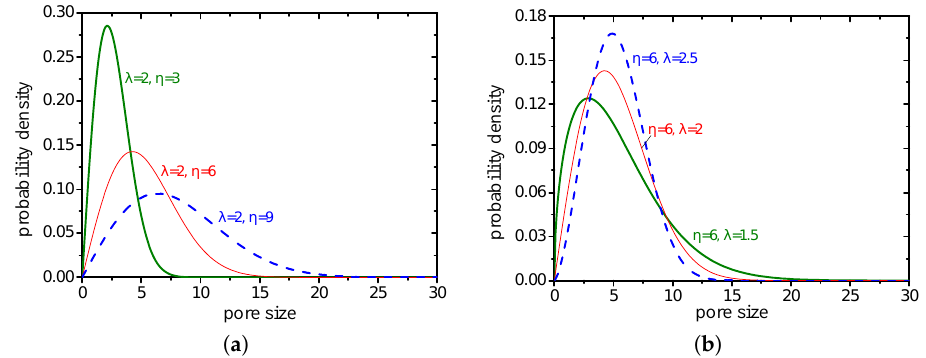
Figure 23. Effects of parameters on Weibull probability density function (( a ) scale parameter η ; ( b ) shape parameter λ ).